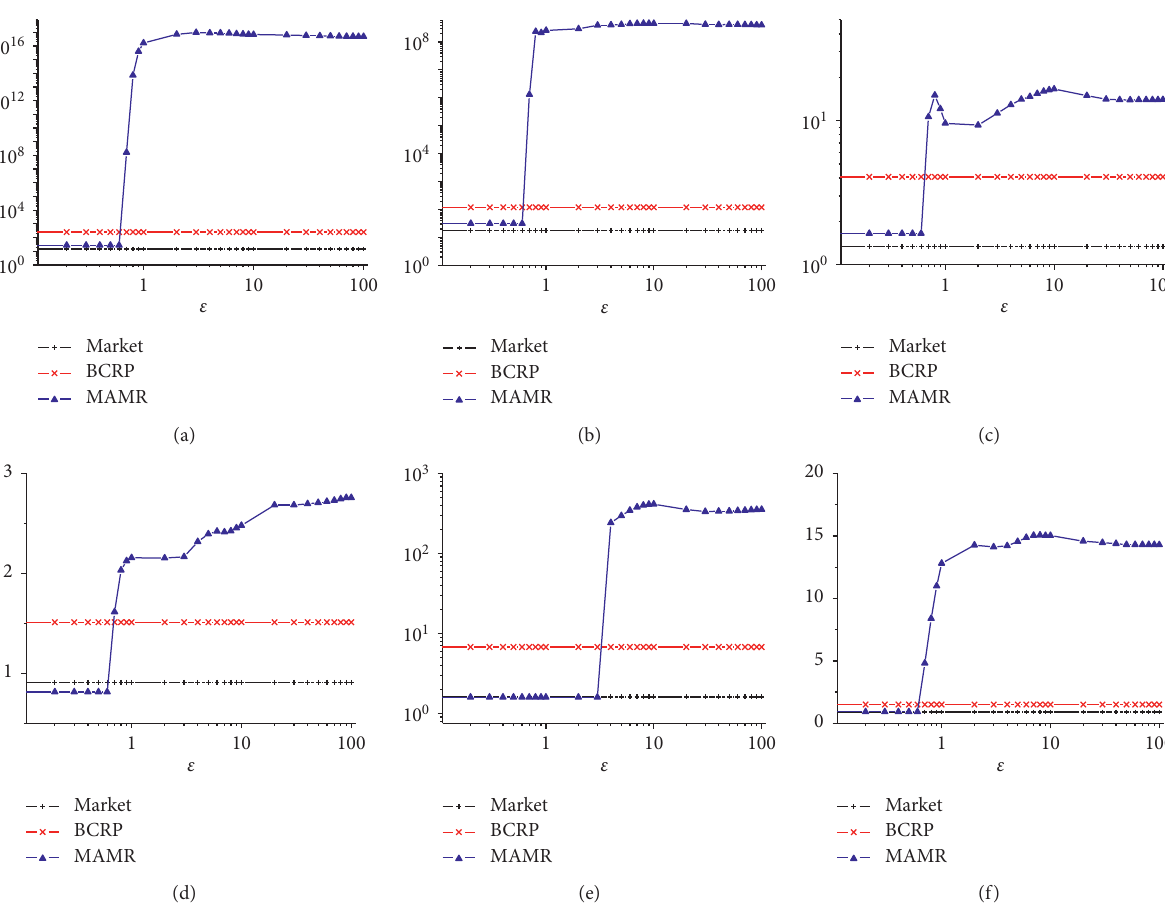
Figure 2: Parameter sensitivity of MAMR with respect to ε with fixed w � 5, C (d) DJIA. (e) TSE. (f)